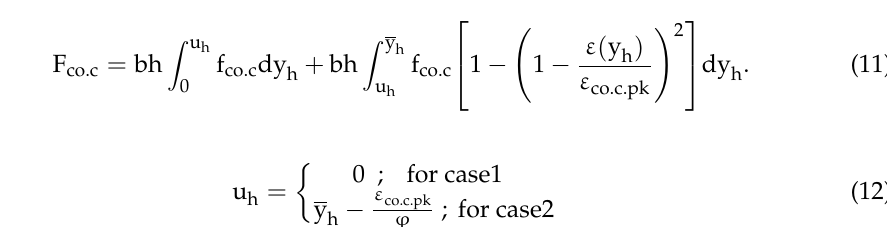
Figure 9. Stress–strain compressive concrete when (cid:3435)ε(y = 0) > ε (cid:2913)(cid:2925).(cid:2913).(cid:2926)(cid:2921) (cid:3439).